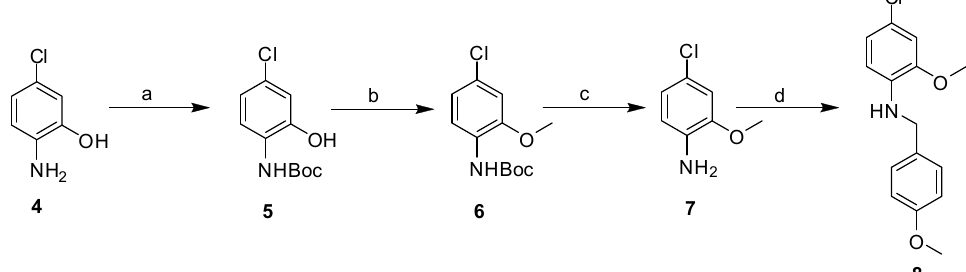
Scheme 2. Synthesis of the chlorinated N -benzylphenyl aniline derivative 8 . Reagents and conditions